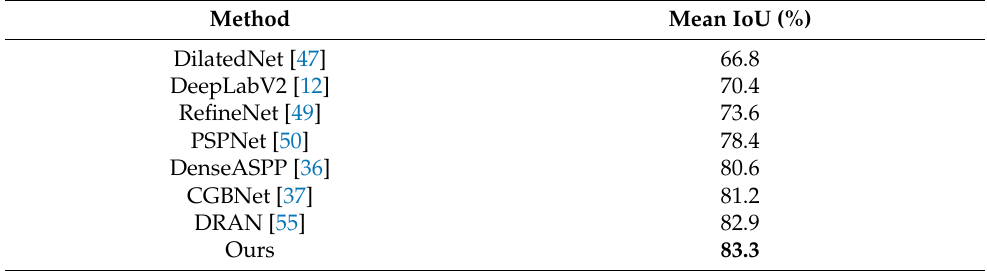
Table 4. Comparison with state-of-the-art methods on Cityscapes dataset. Out method outperforms the